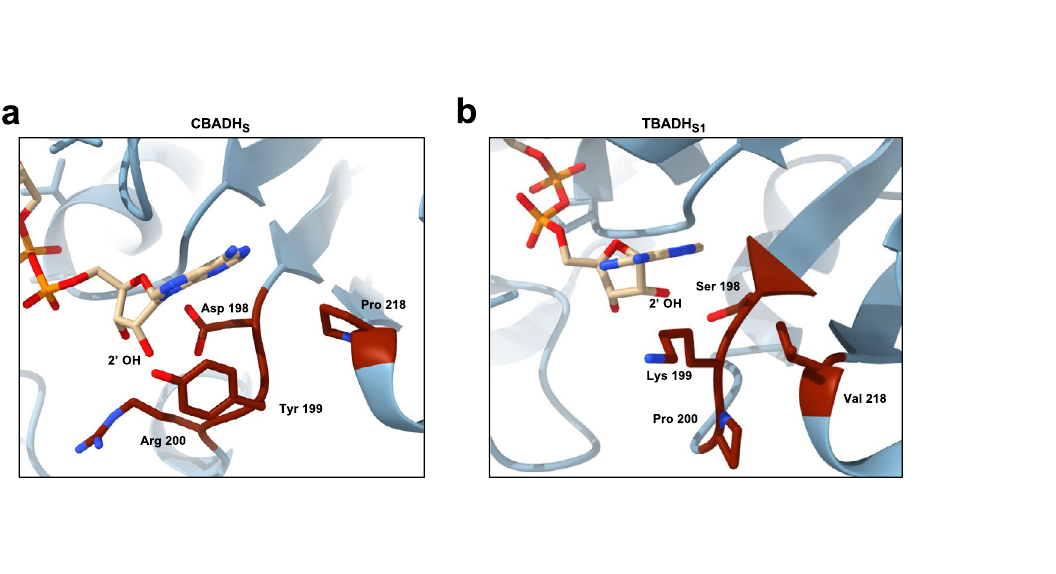
Fig. 3 Crystal structures of CBADH S and TBADH S1 reveal mechanism of cofactor selectivity reversal. a Cofactor binding site of CBADHS with NAD + bound. The substitutions identi fi ed in CBADH S allow for the binding of NAD + but would prevent the binding of NADP + by steric impediments and electrostatic repulsion with the side chains of D198 and Y199. Additionally, the stacked-ring interaction of the adenine moiety with Y218 observed in CBADH WT cannot be established due to the Y218P substitution, possibly enabling a more fl exible binding of the cofactor. b Cofactor binding site of TBADH S1 , with NAD + placed at the same position as NADP + in the structure of TBADH WT . P200 − P201 is modelled as a cis peptide bond. While TBADH S1 can accommodate NAD + in its cofactor binding pocket, the binding of NADP + would be prevented by steric impediments caused by the side chains of S198 and K199. As in CBADH S , the substitution of Y218 prevents the formation of a stacked-ring interaction with the adenine ring of the cofactor, possibly enabling a more fl exible binding of NAD +